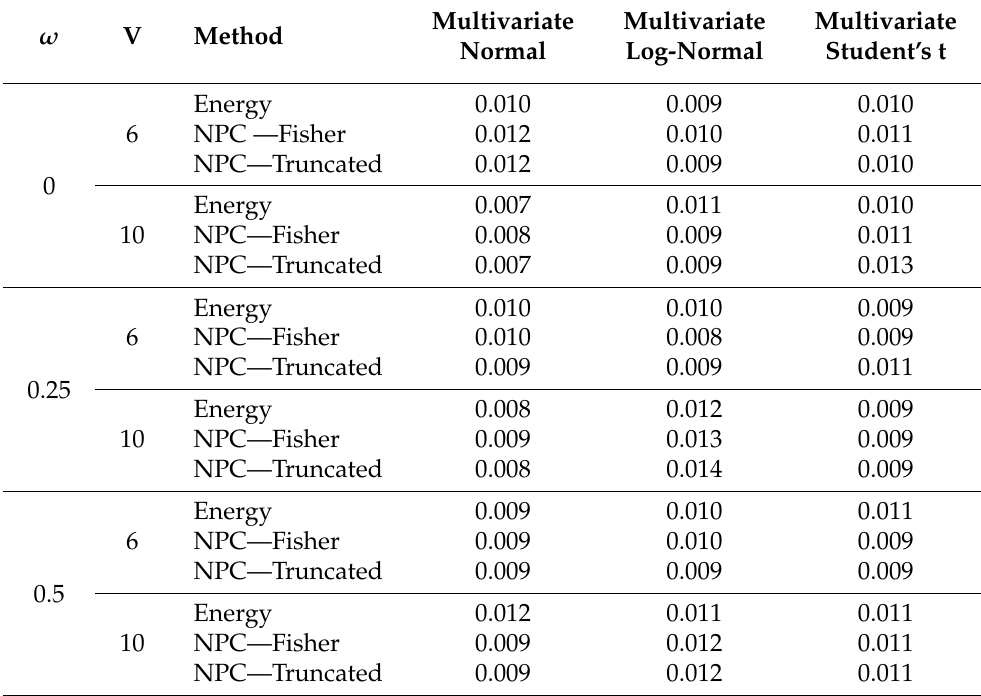
Table 1. Rejection rates with significance level α = 1% under the null hypothesis.